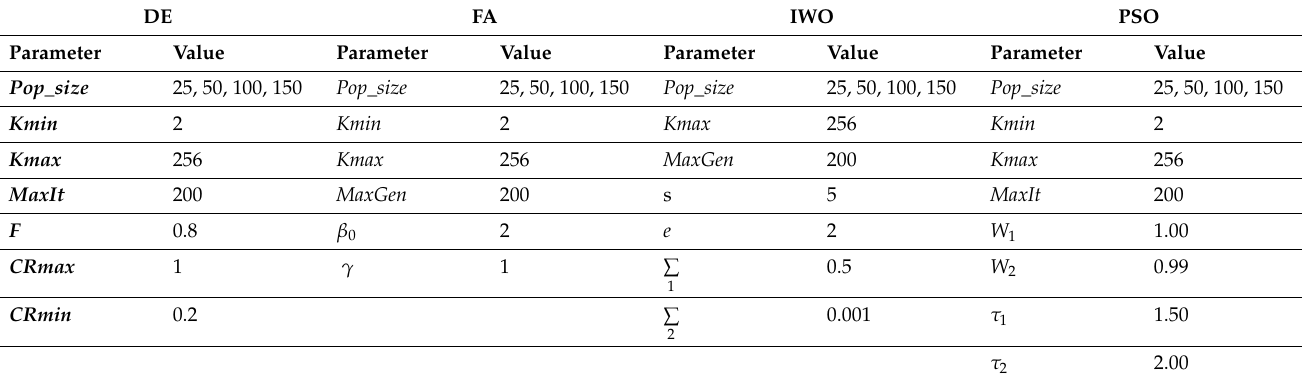
Table 1. The control parameters for competing metaheuristic algorithms.